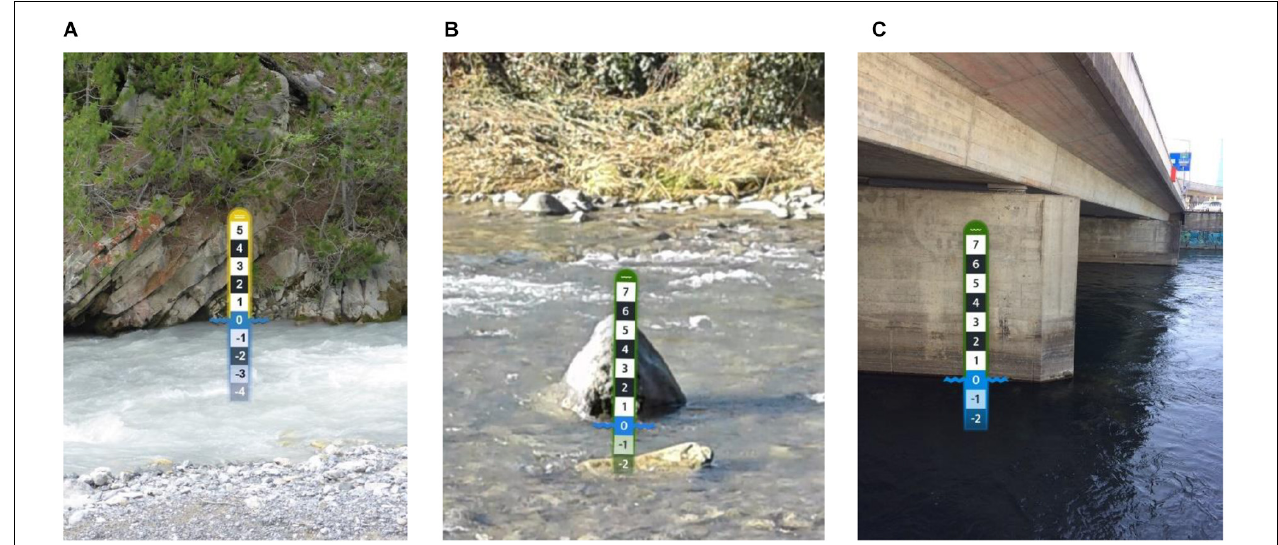
FIGURE 5 | Examples of well-placed virtual staff gauges on (A) the opposite stream bank, (B) a rock in the stream, and (C) a bridge pillar, showing the blue wave at the stream level when the site was established and the positive and negative scale above and below the current stream level, respectively.